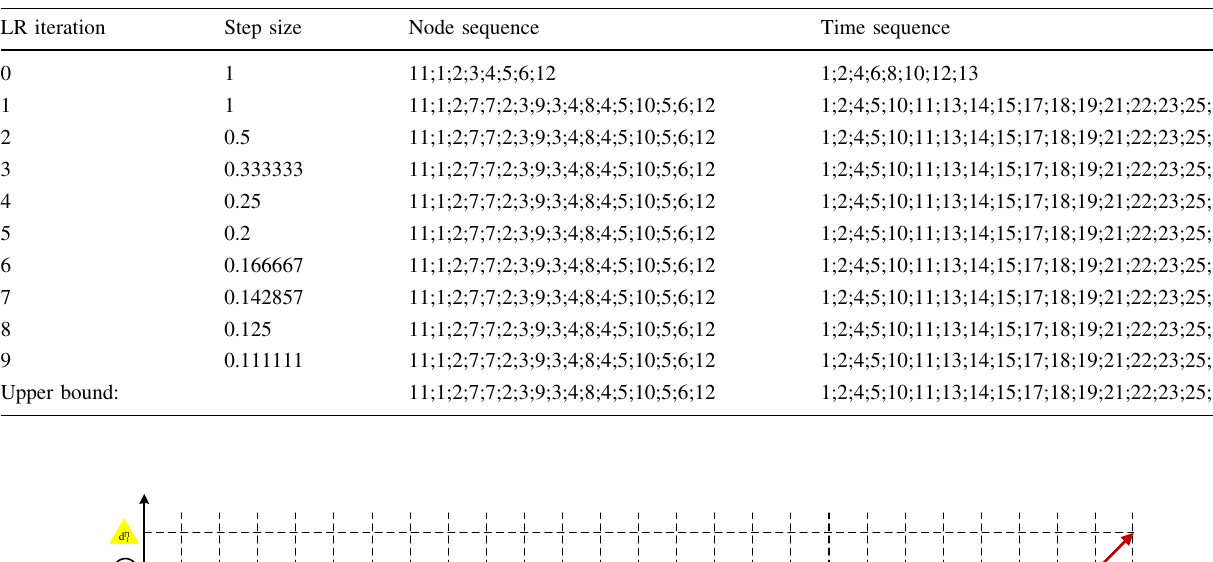
Fig. 11 Network layout and time-window settings for the example with extra passenger waiting time with extra vehicle waiting time Table 8 The evolution of path node sequences and path time sequences for the example with extra vehicle waiting time